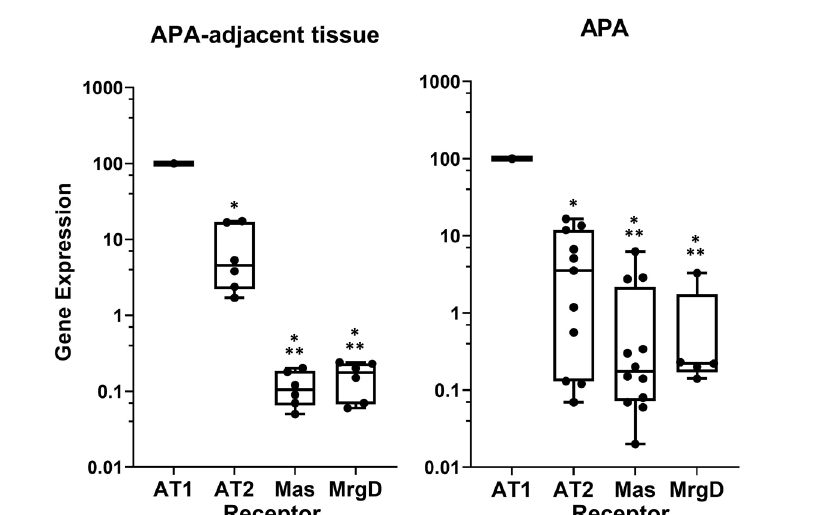
Figure 1. Relative expression of the different angiotensin receptors in human adrenal tissues. Data were obtained by the real-time reverse transcription-polymerase chain reaction (RT-PCR); the different gene expression is calculated with ∆∆Ct method using porphobilinogen deaminase as housekeeping gene and are presented by setting AT1R expression at 100% for comparison. * P < 0.0001 vs. AT1R; ** P < 0.01 vs.